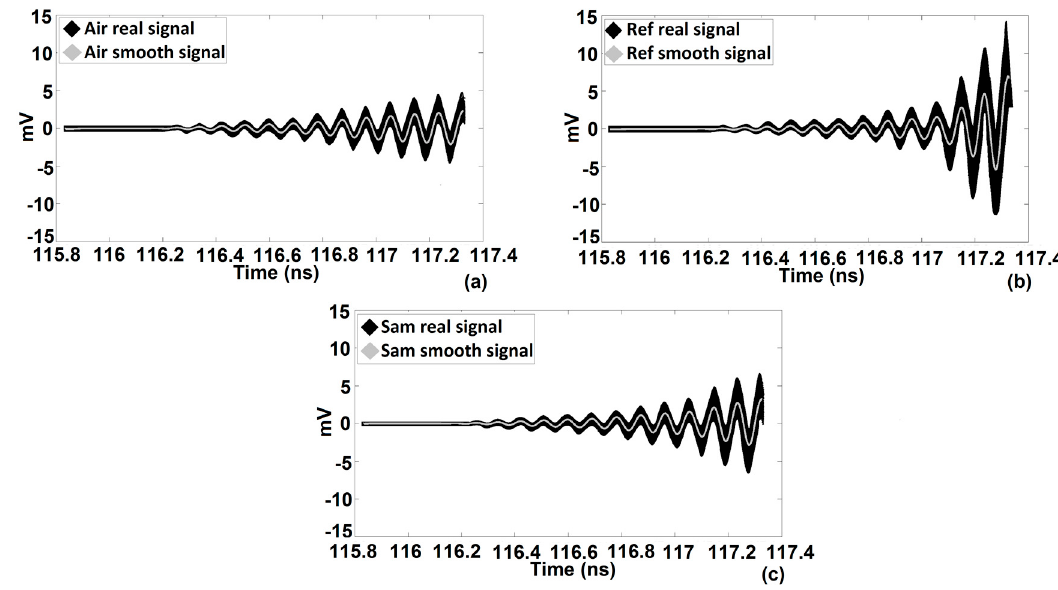
Figure 6. The real and smooth signals of ( a ) Air, ( b ) Ref and ( c ) Sam. Air is the trace due to crosstalk between the transmitter and receiver antennas, Ref is the trace generated from the PSMR and Sam is the trace generated from SUT.